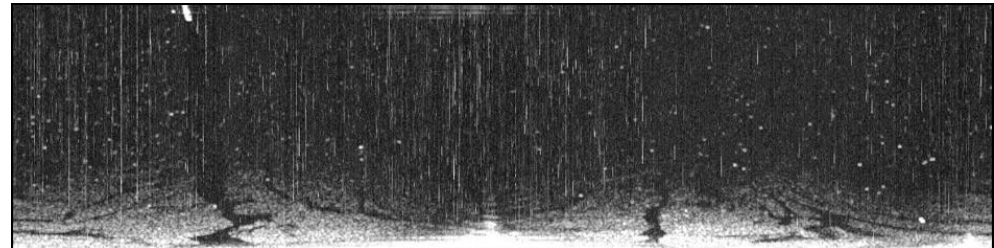
Figure 3. Converted radar image.